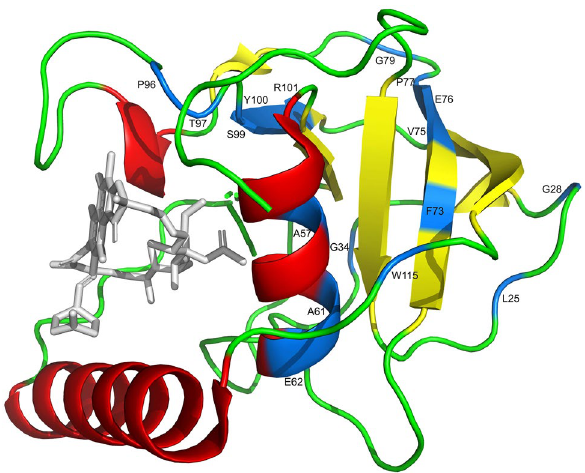
Figure 5. Structure of Arr-ms (PDB 2HW2) highlighting motifs (α-helices, red; β-sheets, yellow; loops, green) and the highly conserved residues identified in all Arr sequences used in the phylogeny (blue residues). Rifampin corresponds to the gray